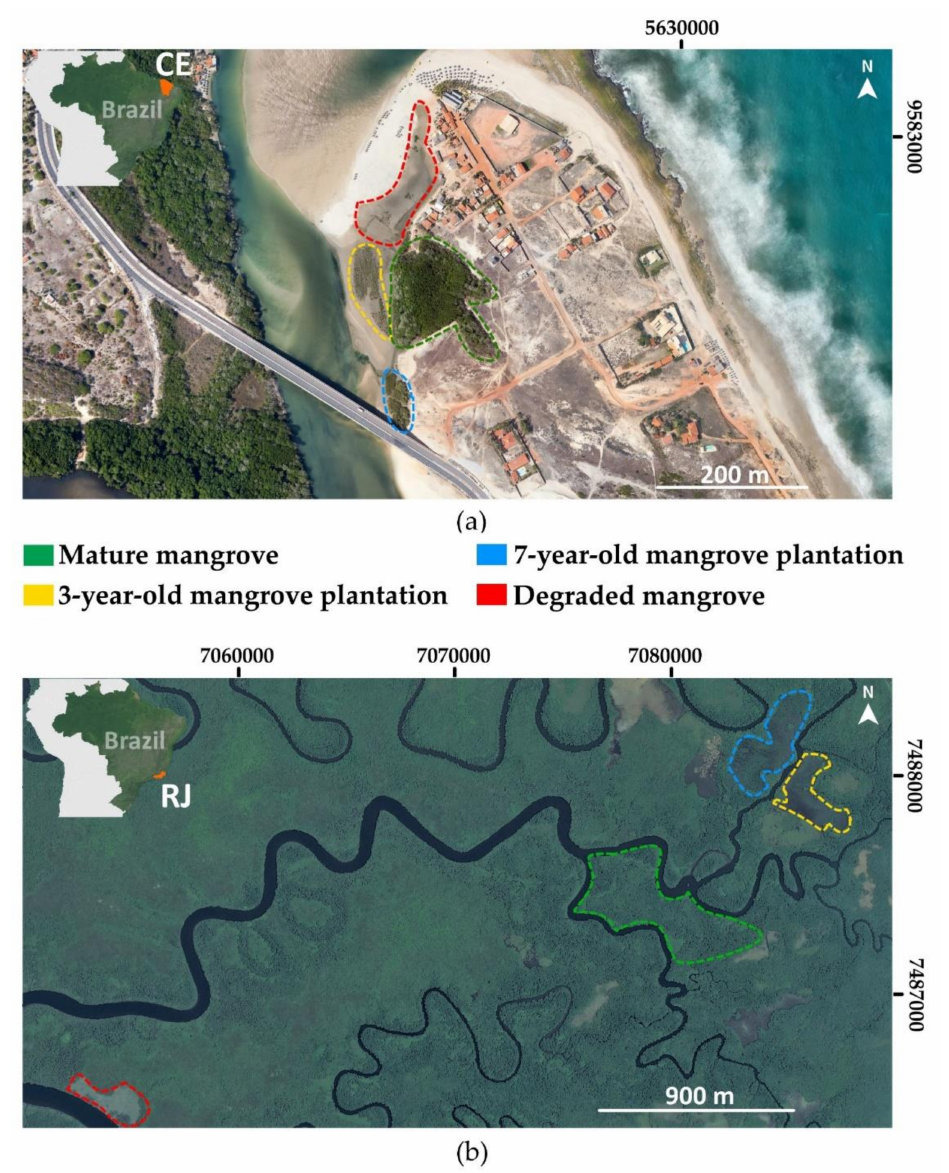
Figure 1. Location of the studied mangrove forests in Cear á (NE-Brazil) ( a ) and Rio de Janeiro (SE-Brazil) ( b ). Different colored plots indicate the different studied scenarios, i.e., degraded and mature mangrove forests and plots at different stages of revegetation (3- and 7-year-old plantations). Satellite images were obtained with Google Earth Pro TM